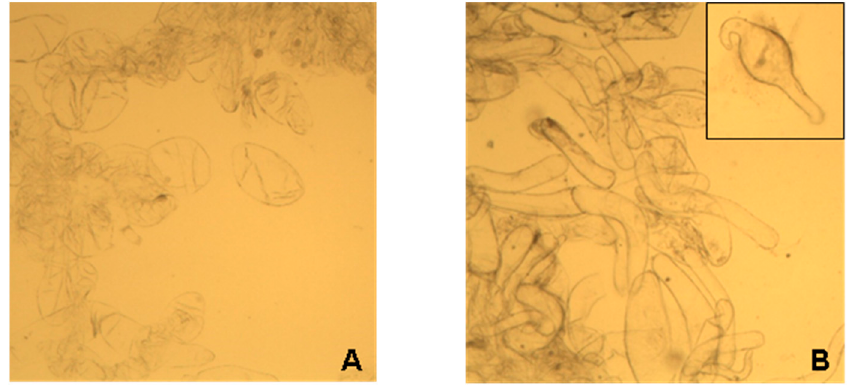
Figure 2. Micrograph of the cells of the callus LA14 ( A ) and LA16 ( B ). Magnification 10×.